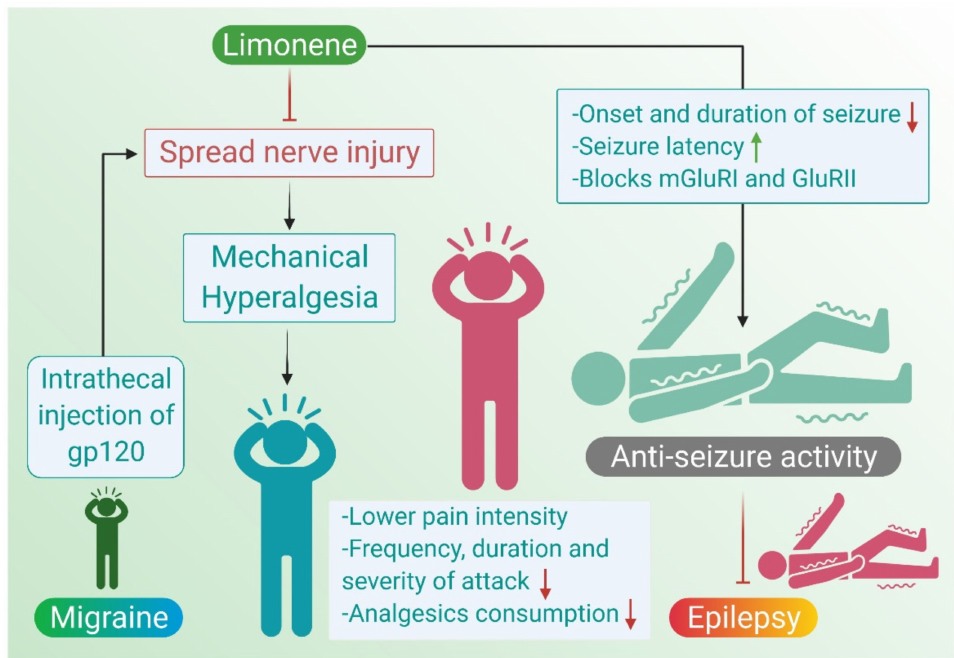
Figure 2. Neuroprotective mechanisms of limonene in migraine and